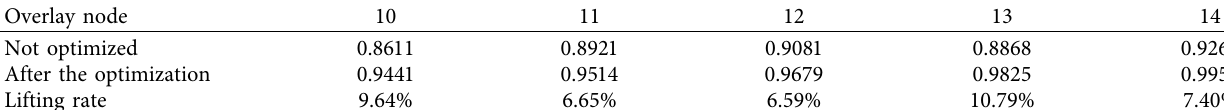
Table 1: Improvement of coverage optimization degree.